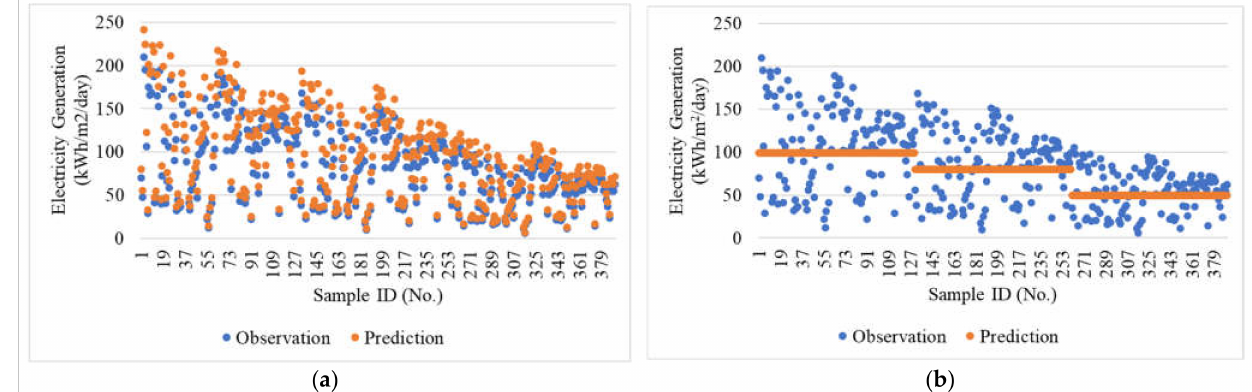
Figure 3. Prediction results: ( a ) solar radiation-based model; ( b ) size-based model.